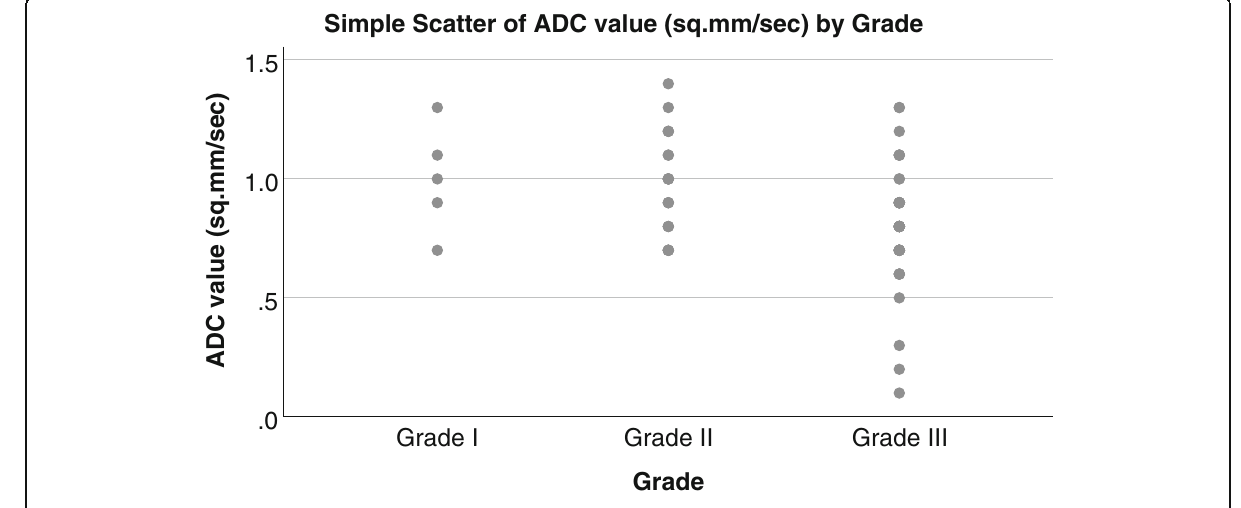
Fig. 7 Simple scatter represents ADC value by grade